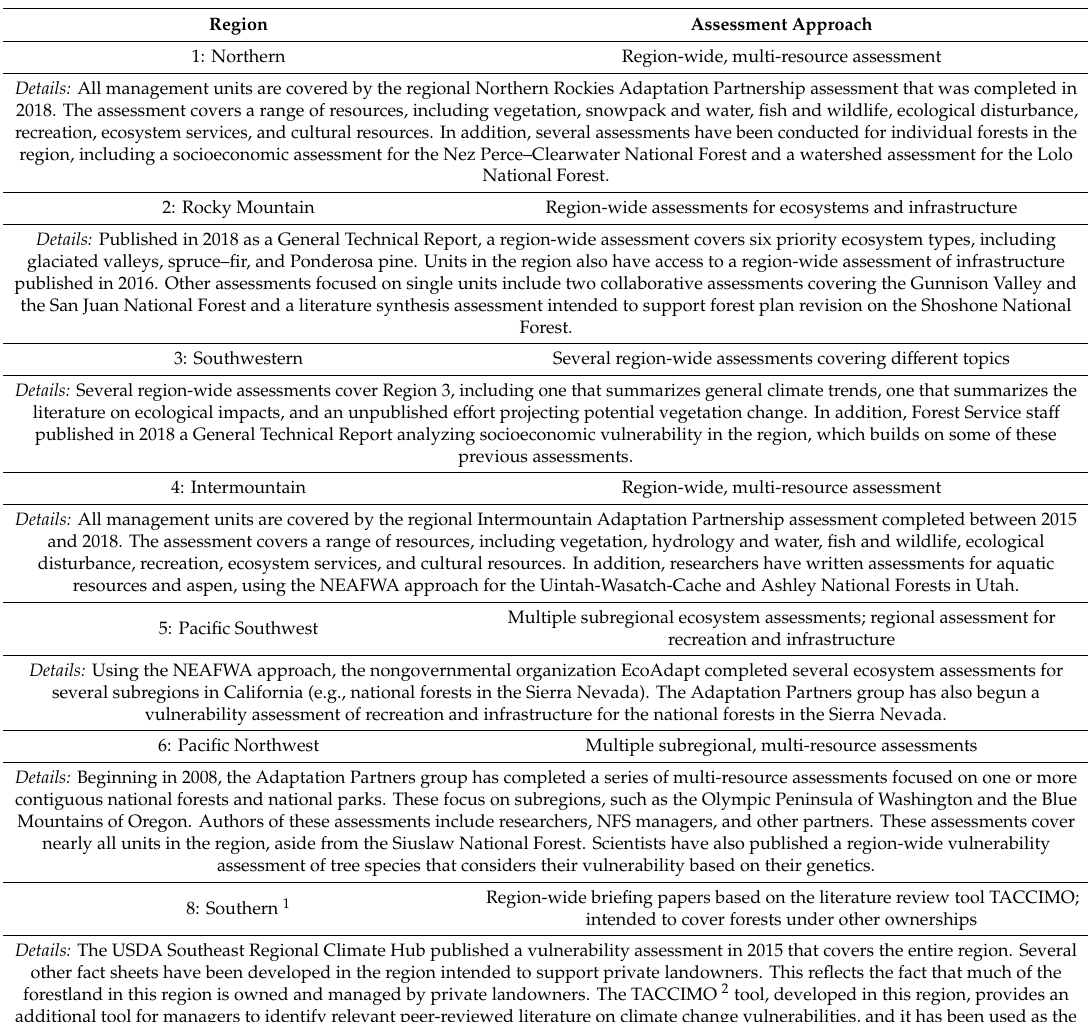
Table 1. Summary of vulnerability assessment approaches by U.S. National Forest System